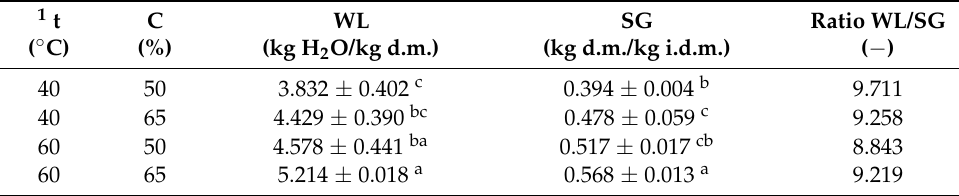
Figure 1. Water loss (WL) during the osmotic dehydration process (process predicted based on Equation (6)). Table 2. Mass transfer parameters after 180 min of OD process.